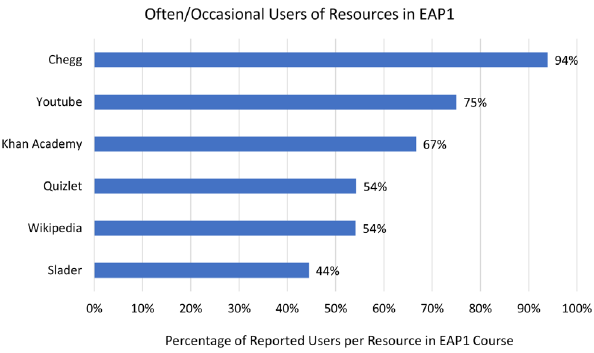
FIG. 10. Percentage of resource users who reported often or occasional usage frequency of that resource in Extended Ana- ¼ 91 lytical Physics 1 ( N EAP 1